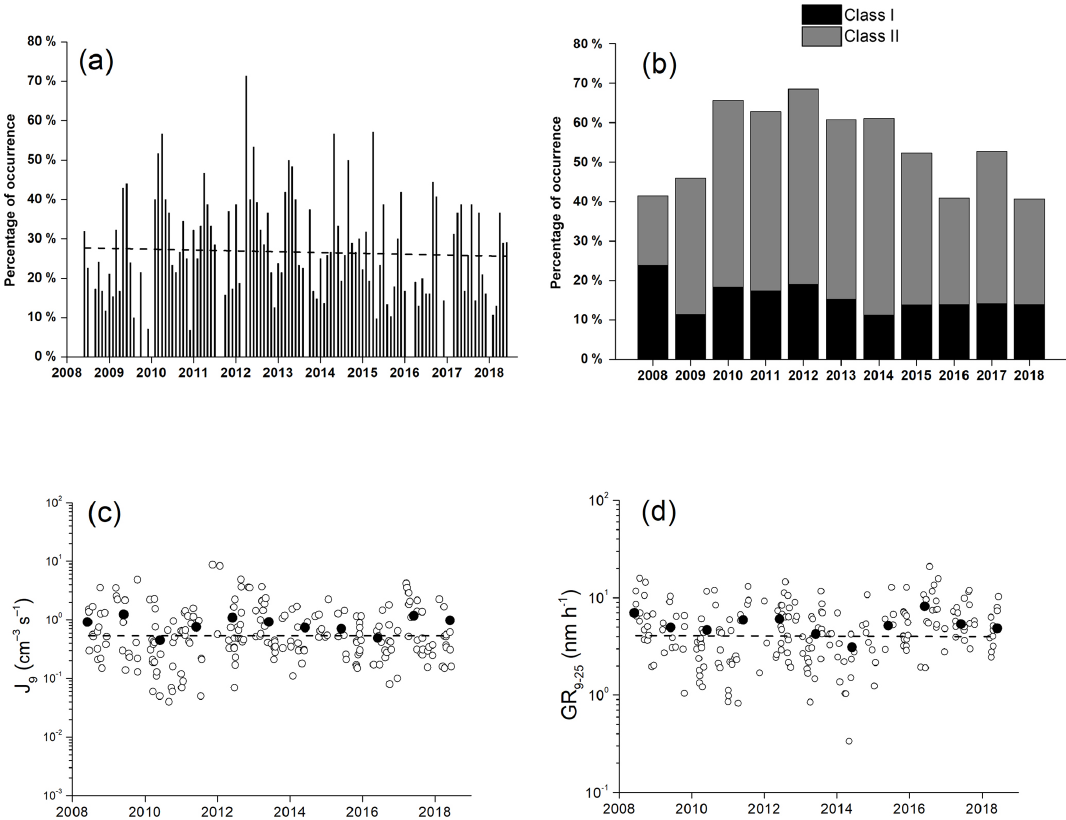
Figure 8. (a) Time series of monthly NPF percentage of occurrence at Finokalia for the years 2008–2018. (b) Annual NPF percentage of occurrence at Finokalia for the period June 2008–June 2018 for Class I and II events. Interannual variation in (c) formation rates of 9nm particles ( J 9 ) and (d) growth rate in the size range 9–25nm (GR 9–25 ) during Class I NPF events at Finokalia for the period June 2008–June 2015 (the solid circles represent annual averages and the dashed lines the linear